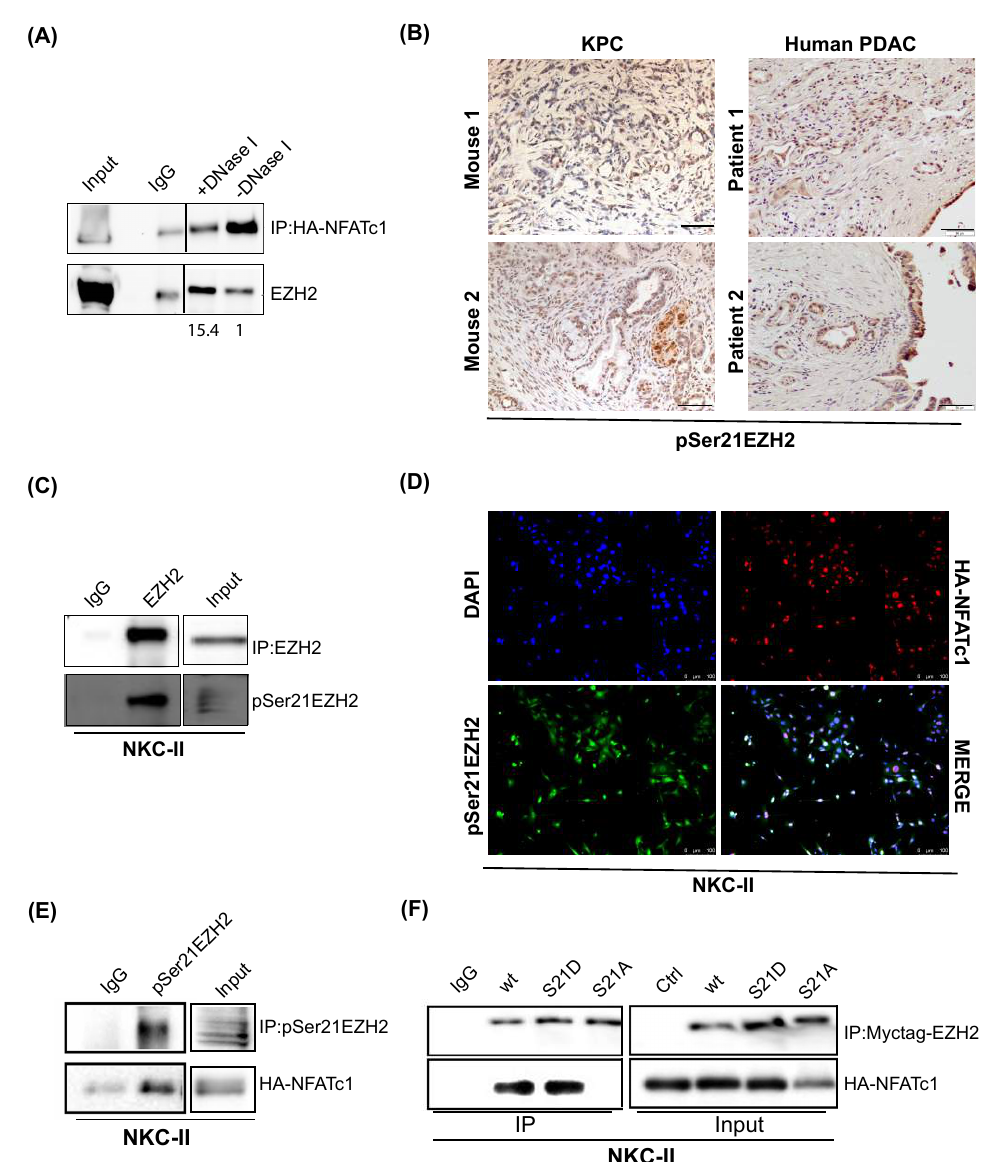
Figure 5. NFATc1:EZH2 complex formation occurs in a chromatin-independent manner and requires posttranslational EZH2 phosphorylation. ( A ) IP of HA-tagged NFATc1 in nuclear NKC-II cell lysates in the presence and absence of DNase I. EZH2 band intensities were normalized to the respective NFATc1 bait protein band intensities using image J (version 1.50b). Subsequently, the band intensity quotient of the DNase I-treated sample was normalized to the quotient determined for the DNase I-negative sample and is illustrated under the Western Blot. IgG was used as control. Lines between IgG and DNAse I samples indicate that the blot has been cut. ( B ) Immunohistochemical analysis of pSer21EZH2 in KPC (left, representative for n = 6 mice) and human (right) PDAC (representative for 3 patients). Magnification 20 × ; Scale bar: 50 µ m. ( C ) IP samples of endogenous EZH2 were stained for EZH2 and pSer21EZH2 to confirm the specificity of the antibody. ( D ) Co-immunofluorescence of pSer21EZH2 and HA-NFATc1 in NKC-II cells. Twenty-five percent of nuclei (308/1228) harbor co-localization. Scale bar: 100 µ m. ( E ) Western Blot analysis upon IP of pSer21EZH2 in NKC-II cells. ( F ) IP of Myctag-EZH2 upon overexpression of EZH2 wildtype (EZH2 wt), a phosphomimicking- (EZH2 S21D), and a non-phosphorylatable- (EZH2 S21A) construct in NKC-II cells. Input samples were loaded to confirm successful overexpression of the EZH2